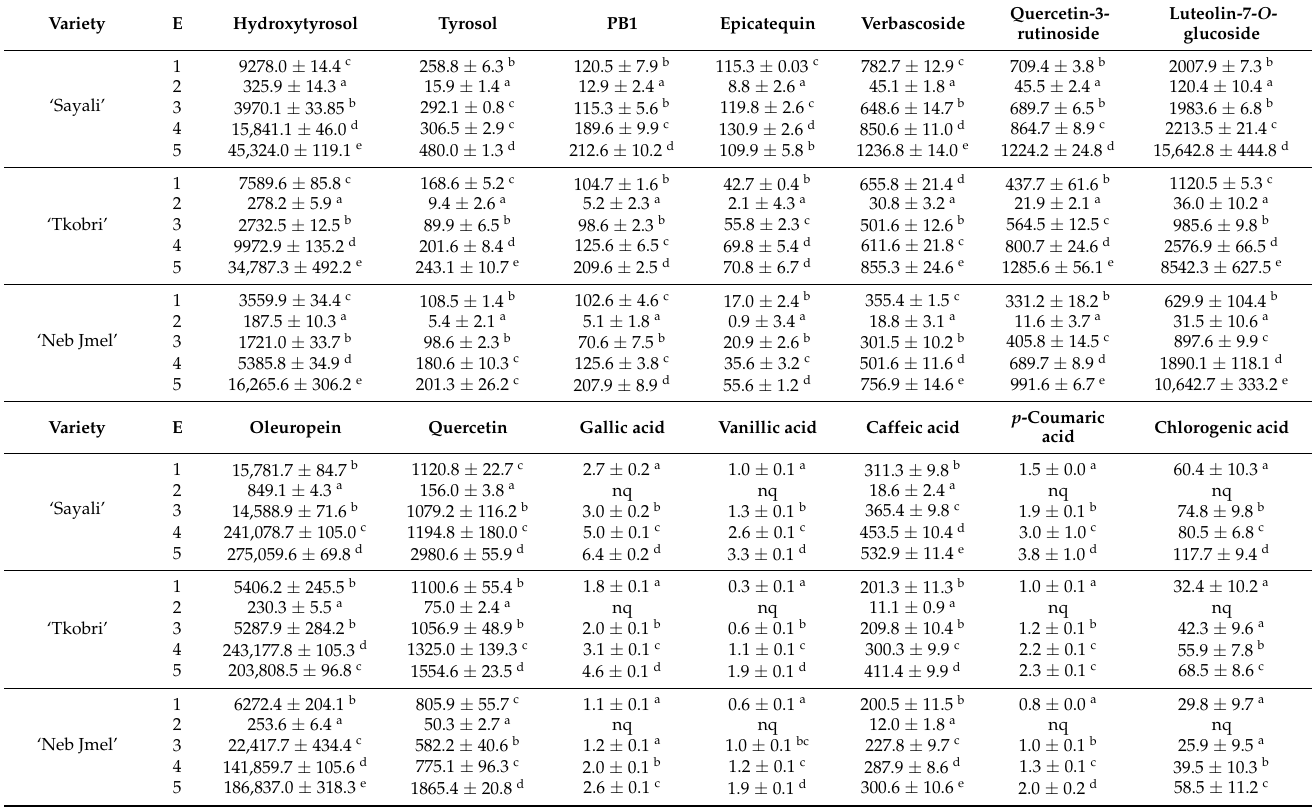
Table 1. Polyphenols’ concentration of olive leaf extract (OLE) extracted by different solvents and aqueous extracts from different varieties (mg 100 g − 1